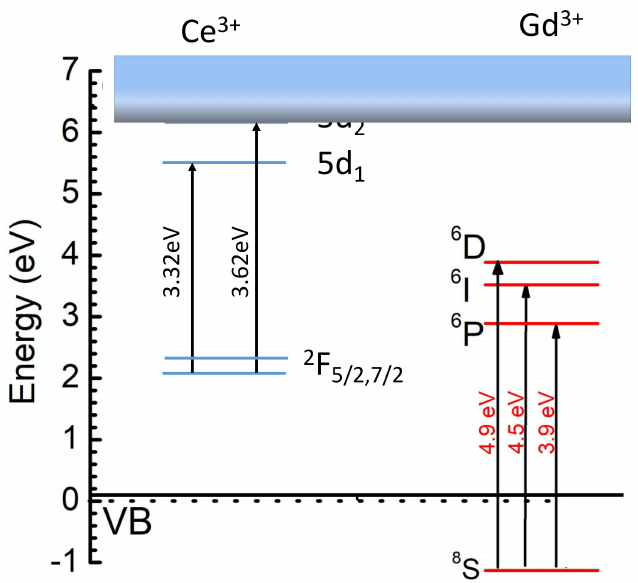
Figure 3. Sketch of the low-energy electronic levels of Gd 3+ and Ce 3+ ions in Ba-Gd-Si glass. At a high concentration of Gd in the glass host, a significant part of the nonequilibrium carriers create Frenkel-type excitons located in the Gd 3+ ions subnet, which has migration capability. The Gd subsystem may contribute to the population of the Ce 3+ radiating level through the interaction of Frenkel exciton and the 2 F 5/2 → 5d 2 transition, however, the resonance is quite poor. Moreover, the 5d 2 levels of the set of Ce 3+ created in the glass are located in a conduction band, so a delocalization of electrons occurs, allowing the nonradiative recombination of nonequilibrium carriers. Holes can be quickly delocalized to the top of the valence band from thr 8 S state [40]. The transfer process, which involves the resonance between 2 F 5/2 → 5d 1 and 6 P → VB top (top of the valence band), is poor as well. This resembles the situation in Gd 2 SiO 5 :Ce, in which the localization is small in the crystalline field in the 7(O) and 8(O) positions of Ce ions, the resonance conditions between Frenkel excitons and 2 F 5/2 → 5d 2 are low, and consequently the light yield is lower than 10,000 ph/MeV [1]. An increase in the crystalline field strength in the Ce 3+ stabilization positions in the glass becomes necessary in future glass modifications. This was demonstrated to be a well-working approach on the transfer from Gd-silicate to Gd- garnet type crystals, in which the light yield has increased 3 times and even more [41]. will allow a multi-seed glass crystallization at volume and, on the other hand will